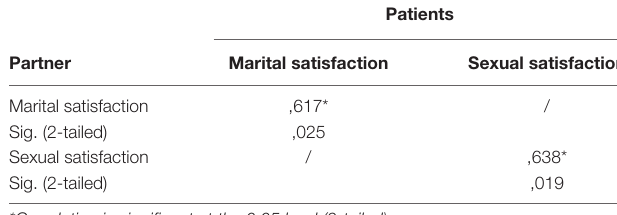
TABLE 5 | Patient-partner correlation of marital satisfaction/sexual satisfaction.